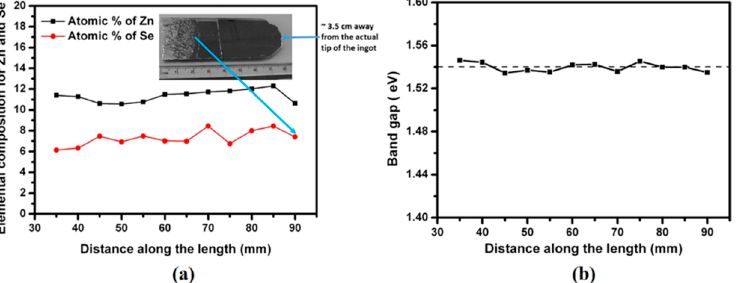
Figure 4. Variation of concentration (at%) of Se and Zn, ( a ) and bandgap ( b ) along the ingot axis of a THM grown Cd 0.9 Zn 0.1 Te 0.97 Se 0.02 crystal (Adapted from ref. [42] Copyright 2019 Nature